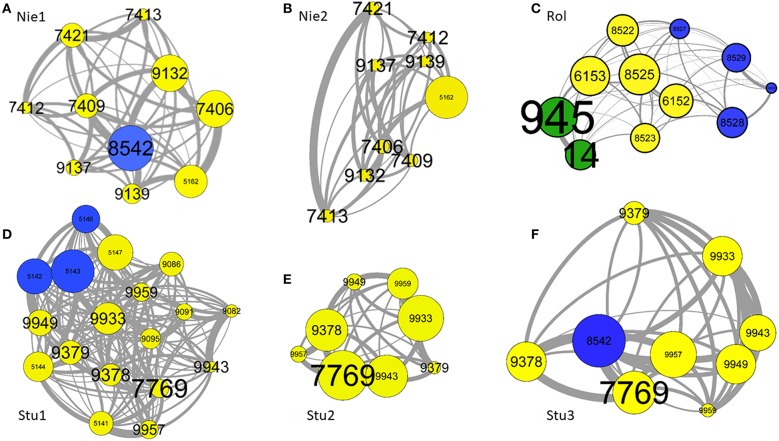
Examples of six group compositions: (A) Nie1, (B) Nie2, (C) Rol, (D) Stu1, (E) Stu2, and (F) Stu3. One node represents one individual, each identified by a number (label). The links between nodes are dyadic associations. The size of nodes depends on the strength of associations but are relative to each group composition (the strengths are not comparable between networks). The thickness of links depend on the weight of dyadic associations. The size of labels increases with the age of individuals. Yellow, blue, and green node colors indicate females, males and castrated males, respectively. Individuals are positioned according to their weight of associations: two individuals located close to each other share a stronger dyadic association than distant individuals. Graphs were created using Gephi 0.91 (59) with the “ForceAtlas” spatialization package.